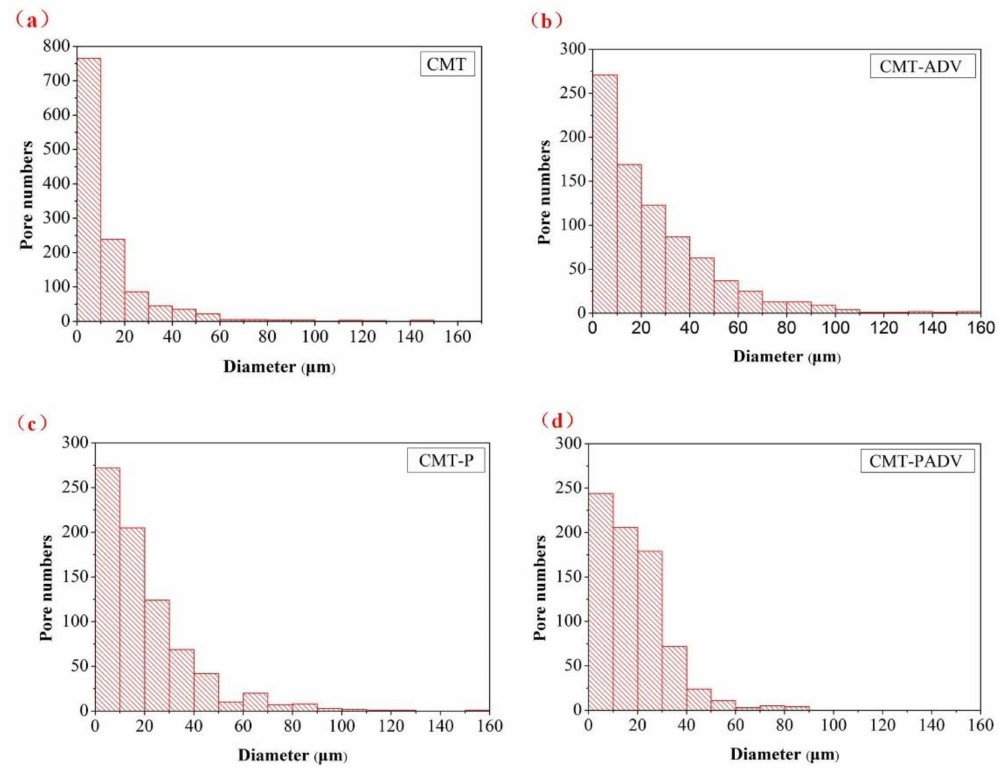
Figure 6. Pore size distribution in numbers for the 2219 aluminum alloys fabricated by different arc modes: ( a ) CMT; ( b ) CMT-ADV; ( c ) CMT-P, and ( d ) CMT-PADV.